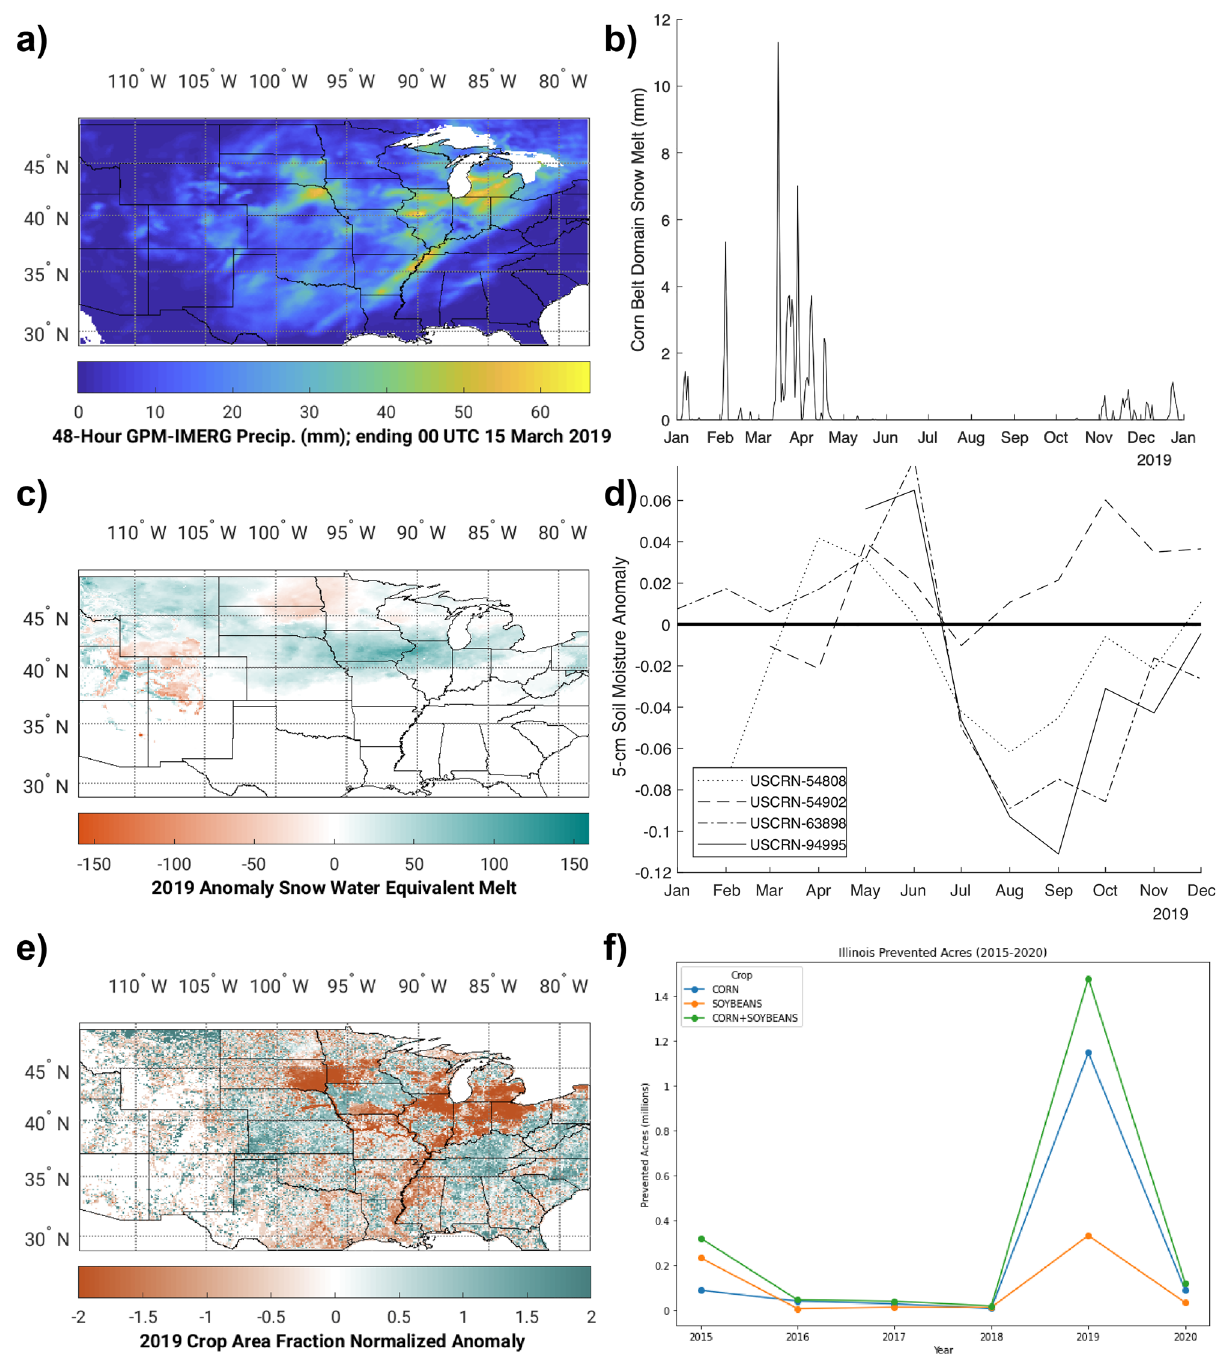
Figure 2. Observed Impacts of the 2019 Mississippi Basin Flood Event. IMERG Precipitation for March 14–15 (top left, a ), University of Arizona SWE melt over the corn belt domain (top right, b ), University of Arizona (Dawson et al. 2016) SWE snowmelt anomalies (compared to 2016–2020) for 10 March to 29 March 2019 (middle left, c ), USCRN soil moisture anomalies for four sites in the corn belt domain (middle right, d ), 2019 Crop Area Fraction for Soy and Corn Standardized Anomalies based on the CropScape dataset (bottom left, e ), and USDA Farm Service Agency (FSA) prevented acres (bottom right, f ) from 2015 through 2020 for the State of Illinois are shown. Map panels were generated by Matlab version